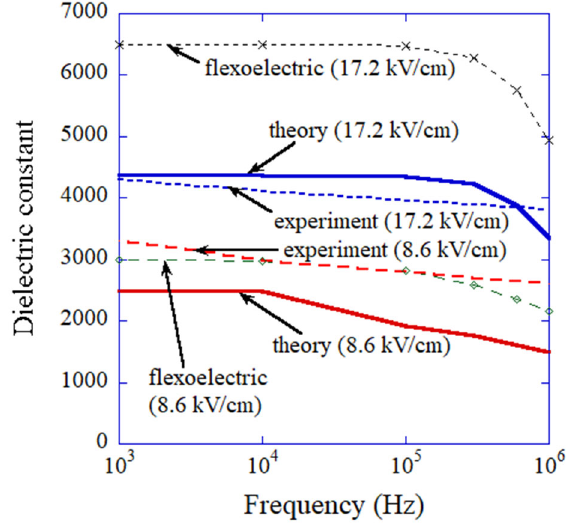
Figure 11. Dielectric constant as a function of frequency. The numerical results on dielectric constant solely by flexoelectric polarization are also shown. The experimental data are also shown for comparison. Reprinted with permission from Ref. [167]. Copyright 2020, MDPI.